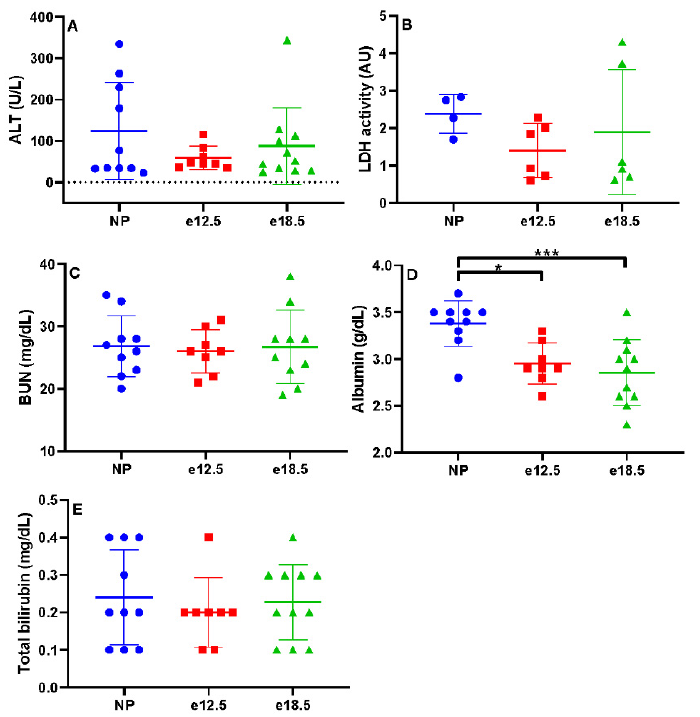
Figure 1. Biochemical markers of liver disease in NP, e12.5, and e18.5 BPH/5 mice ( n = 8–15 per group). There was no significant difference in plasma levels of ( A ) alanine amino transferase (ALT), ( B ) lactate dehydrogenase (LDH), ( C ) blood urea nitrogen (BUN), ( D ) albumin, and total bilirubin ( E ) at any time point. * p < 0.01, *** p < 0.001, ns, not significant.